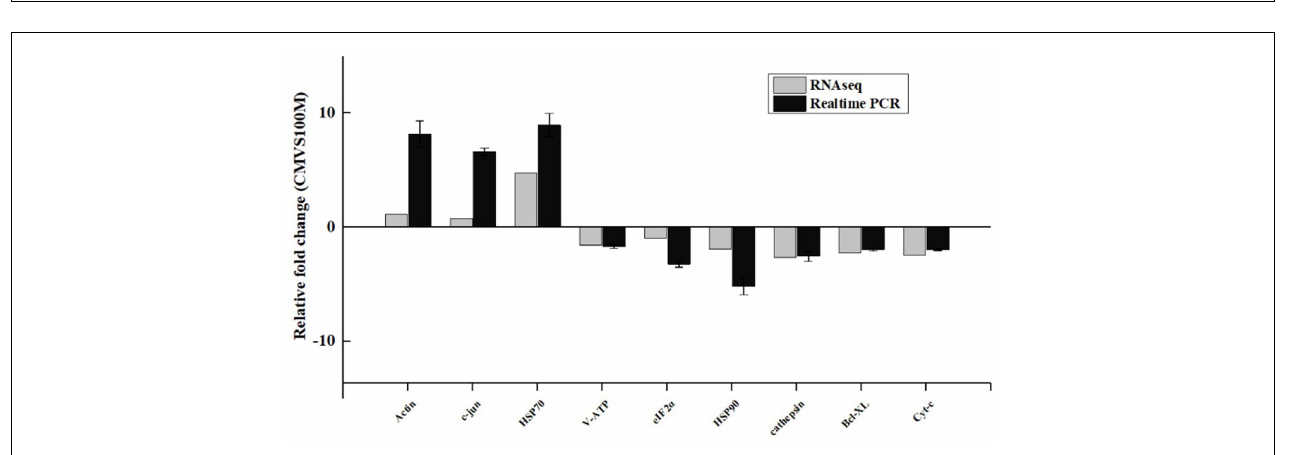
FIGURE 6 | Comparison of gene expression data between RNA sequencing (RNA-Seq) and quantitative real-time reverse transcription PCR (qRT-PCR). Data are presented as mean ± standard deviation (SD) of three replicates.